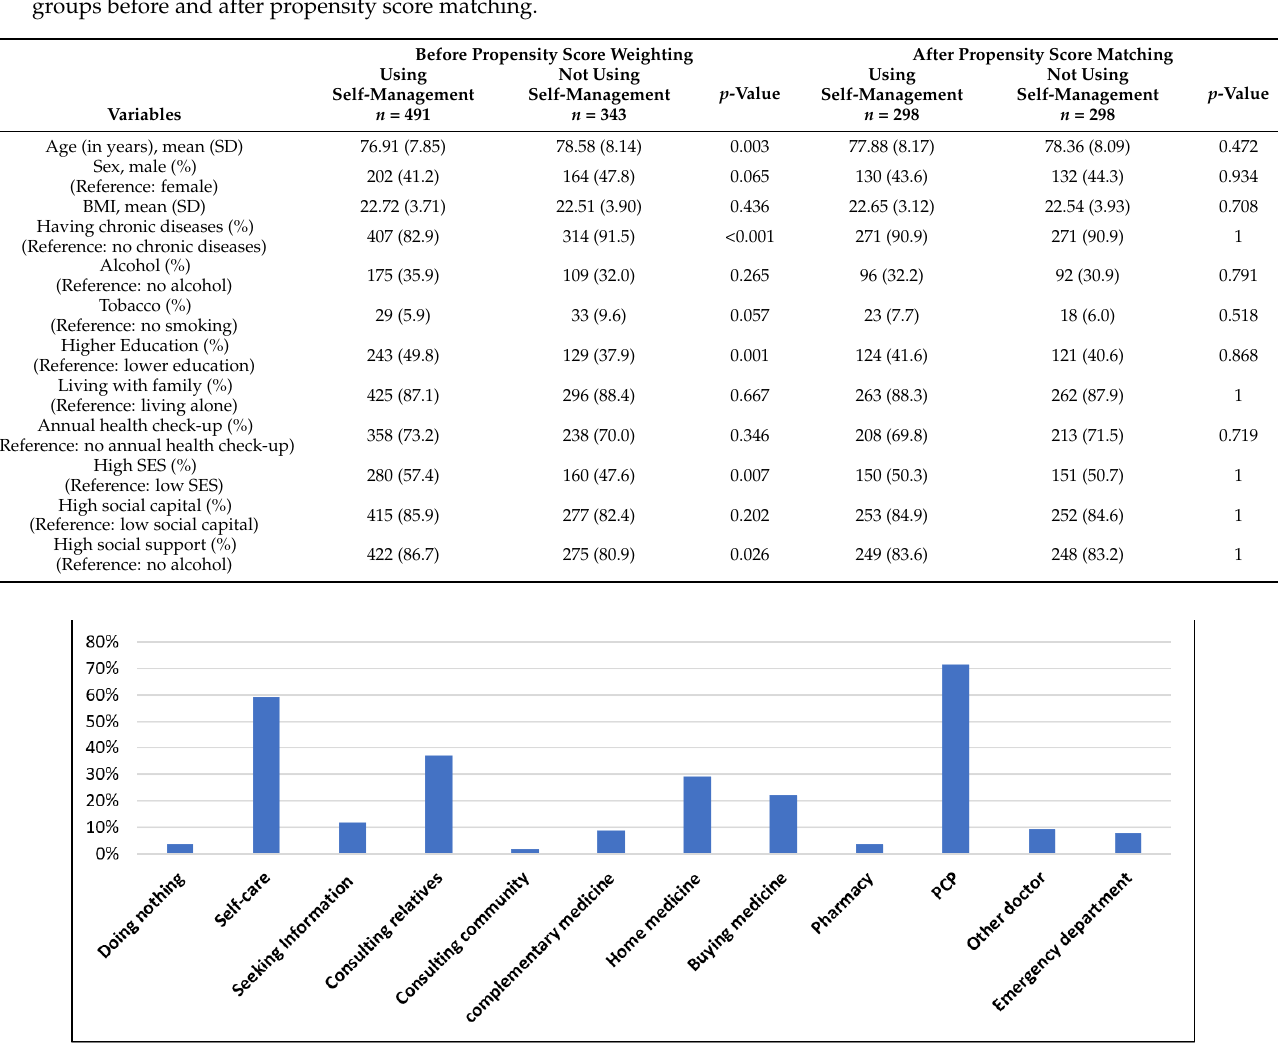
Figure 2. The percentage of each HSB regarding mild symptoms. Note: consulting relatives, consulting family and friends;